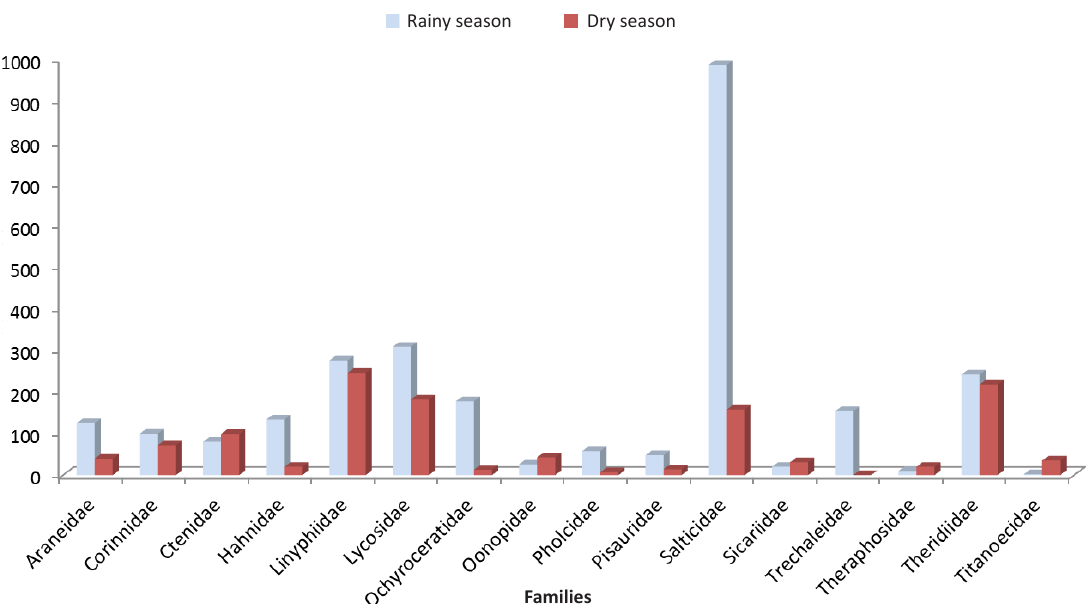
Figure 9. Total abundance of major spider families according to the season of collection in the Ecological Park Centennial Jatoba. (U=87; P=0.06)